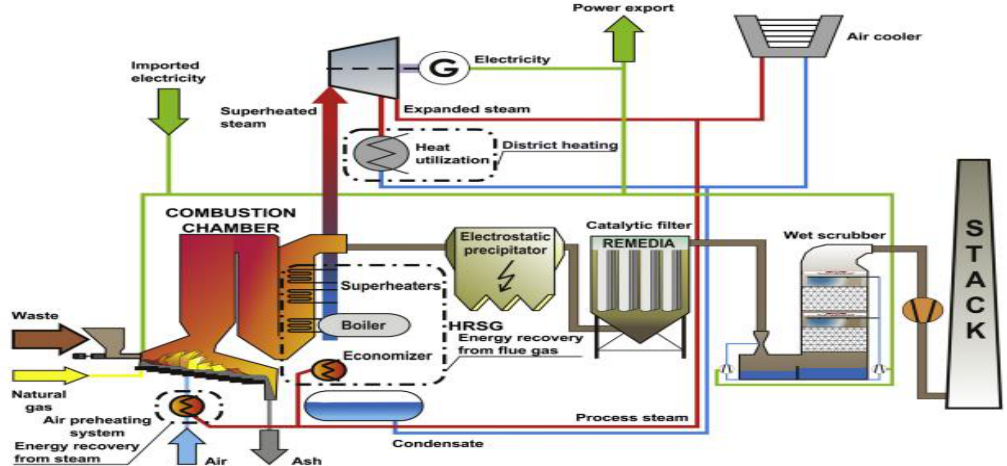
Figure 1: Incineration plant to produce electricity and heat from MSW [15].